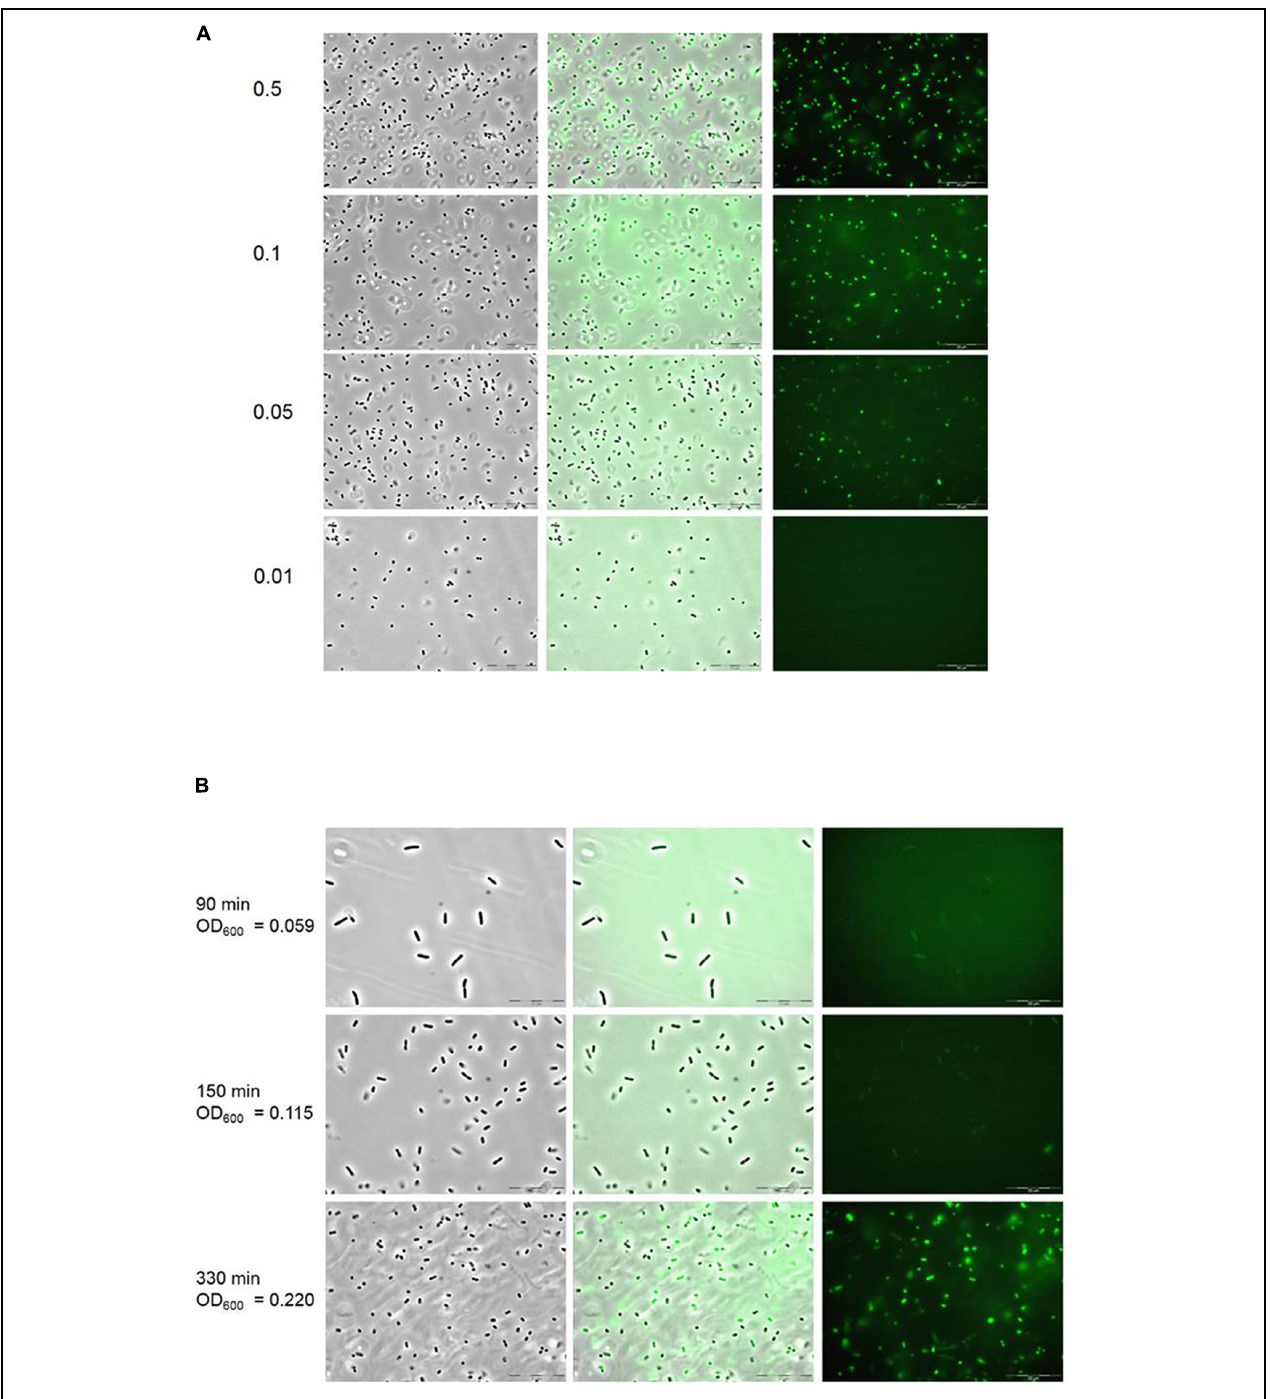
FIGURE 3 | Microscopic survey of strain 14028 P pduA :: gfp at varying concentrations of 1,2-PD and glucose. (A) Images were obtained 270 min post-inoculation in VB-NCE-YE medium supplemented with trace elements, tetrathionate, and 0.5, 0.1, 0.05, and 0.01 mM 1,2-PD as indicated on the left. The OD 600 of the samples ranged from 0.143 to 0.151. (B) Repressing influence of glucose concentrations on the induction of P pduA by 1,2-PD. Cells were grown in the presence of 1 mM 1,2-PD and 1 mM glucose and monitored at the indicated cell densities and time points post-inoculation.